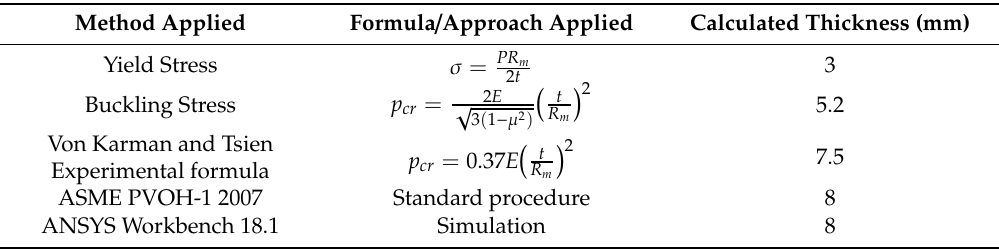
Table 3. Results of the various methods applied for a thickness calculation.